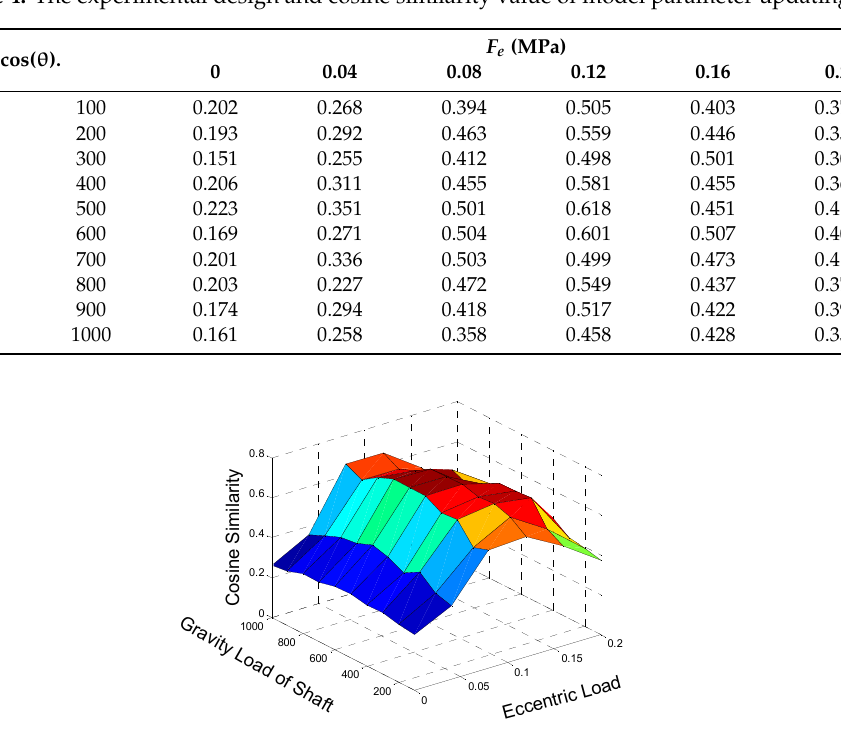
Table 3. Contact parameters and loading parameters for the FEM model.